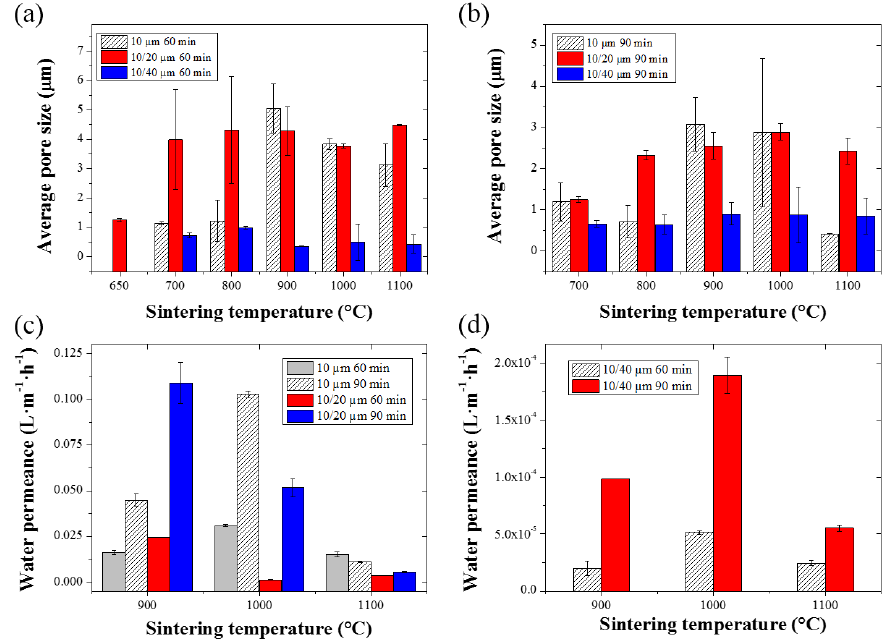
Figure 8. Average pore size measurements of the SS HFs as a function of the sintering temperature, for ( a ): 60 min and ( b ): 90 min sintering time. Water permeance values of ( c ): the SS 10 and SS 10/20 HFs as a function of the sintering temperature and time. ( d ): Pure water fluxes of the SS 10/44 HFs as a function of the sintering temperature and time.